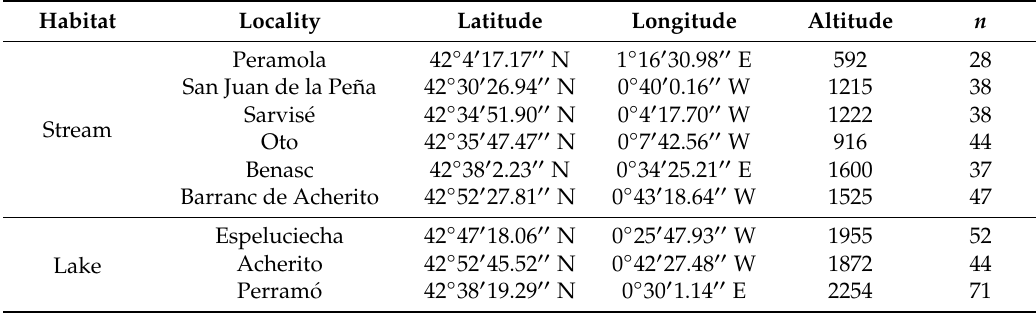
Figure 1. Localization of the sampled localities of Calotriton asper populations. Stream populations: 1 Peramola; 2 San Juan de la Peña; 3 Sarvisé; 4 Oto; 5 Benasc; 6 Barranc Acherito. Lacustrine populations: 7 Espeluciecha; 8 Acherito; 9 Perramó. See Table 1 for details on each locality. Table 1. Latitude, longitude, altitude, and number of individuals (339 in total) for each locality and habitat.